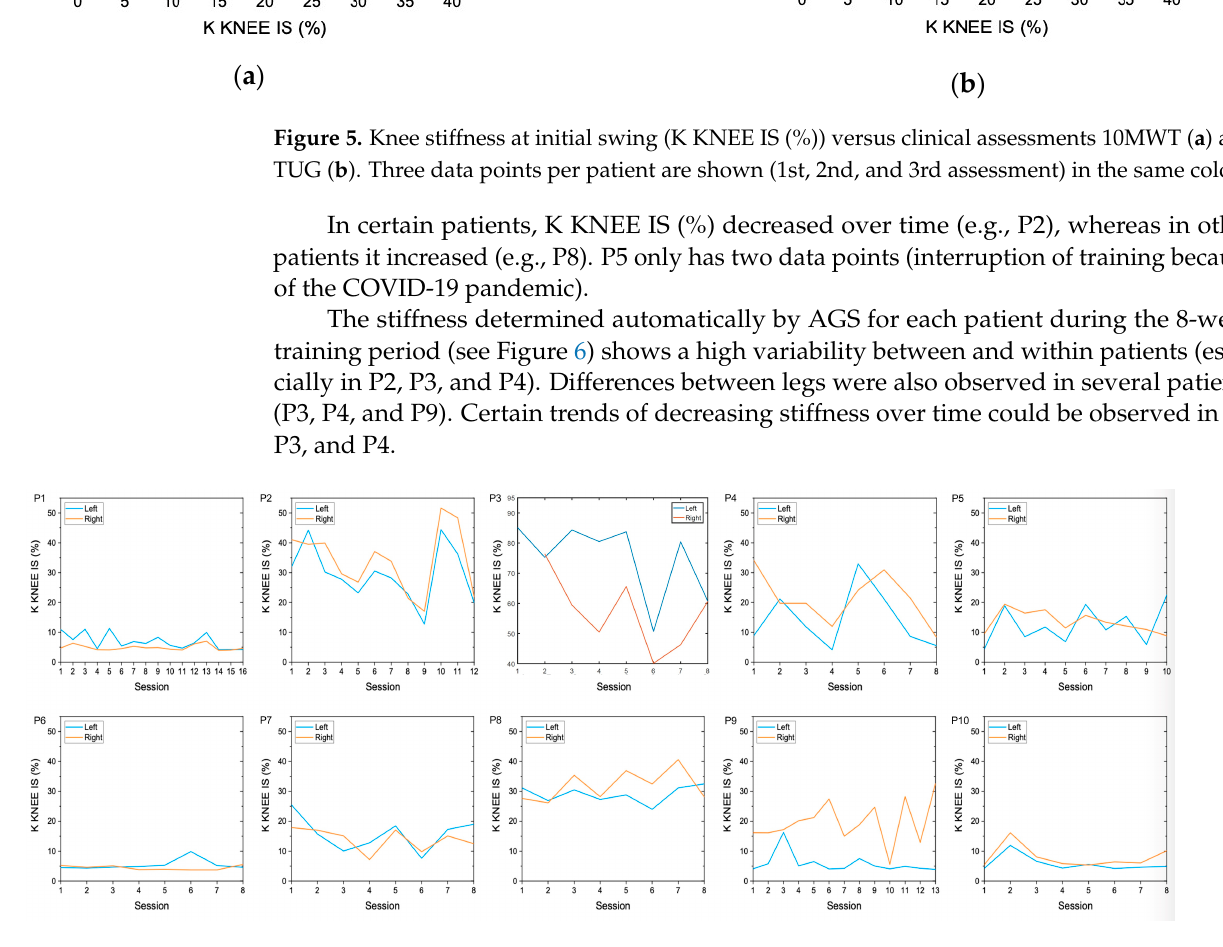
Figure 6. The knee stiffness of the initial swing phase (K KNEE IS (%)), which was chosen as the best